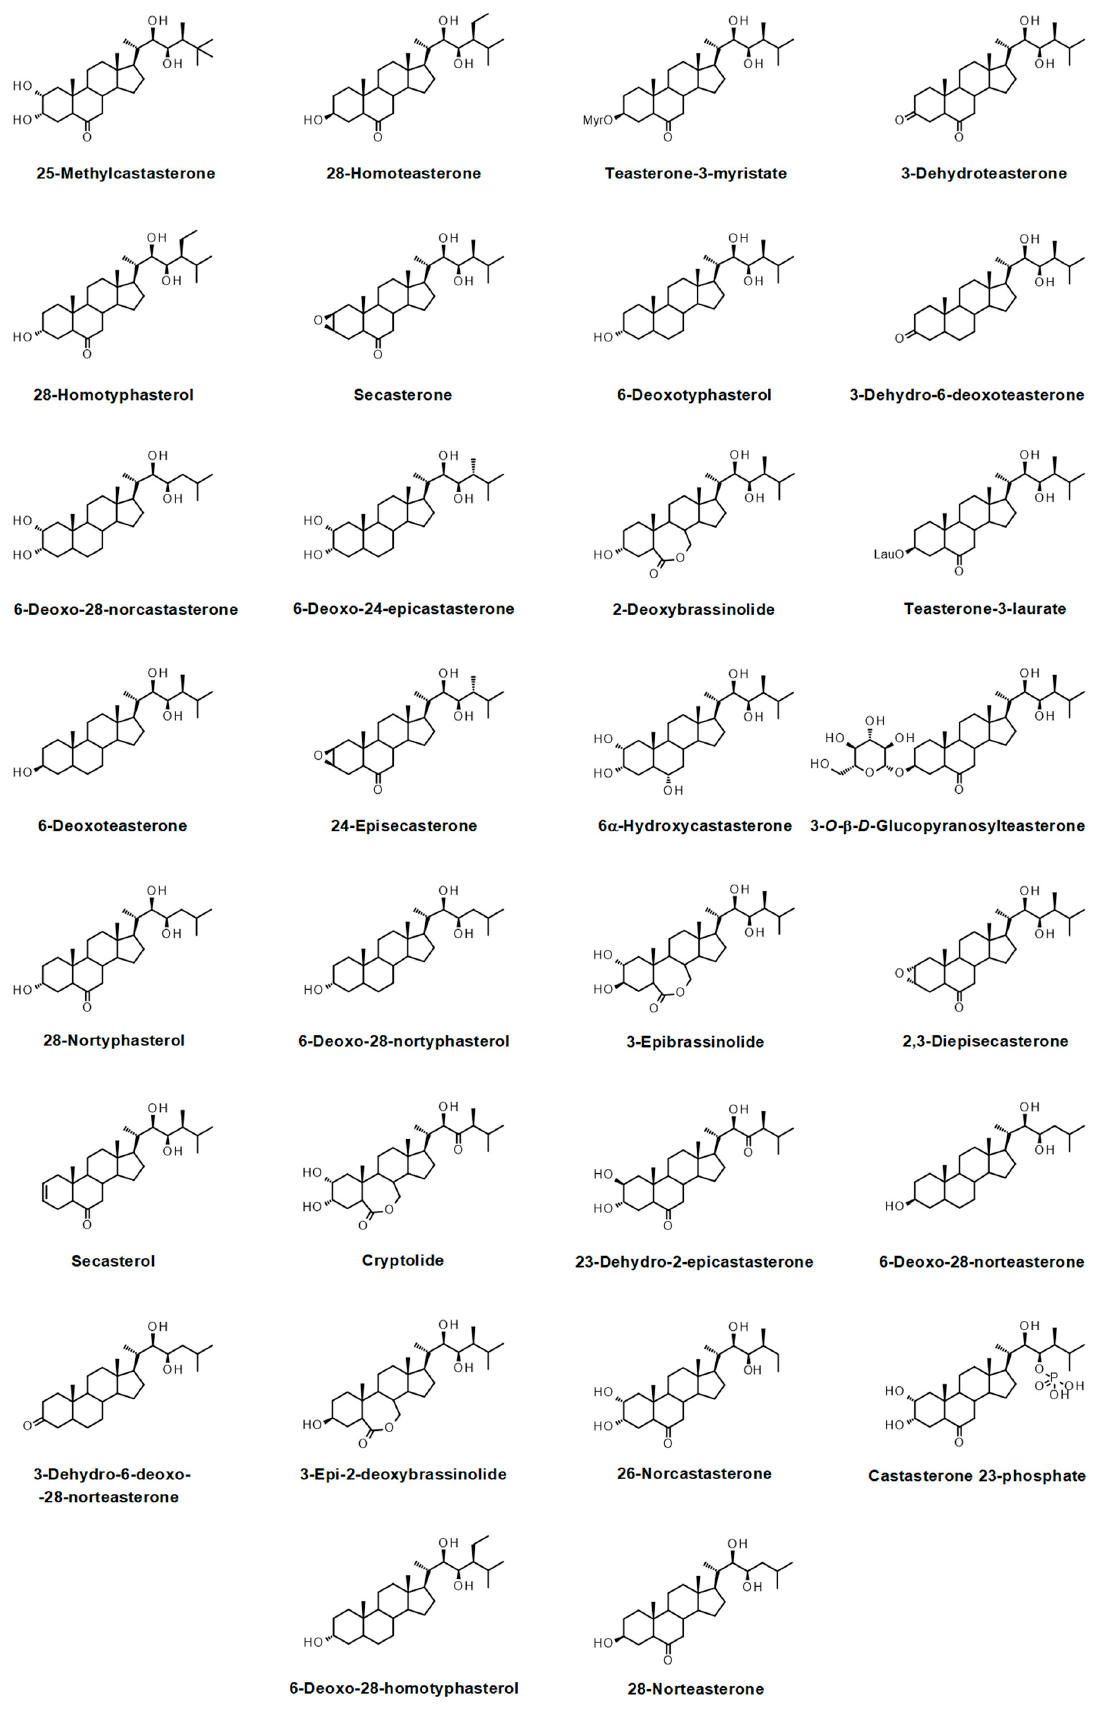
Figure 1. Cont . Figure 1. Natural brassinosteroids isolated from or detected in plant